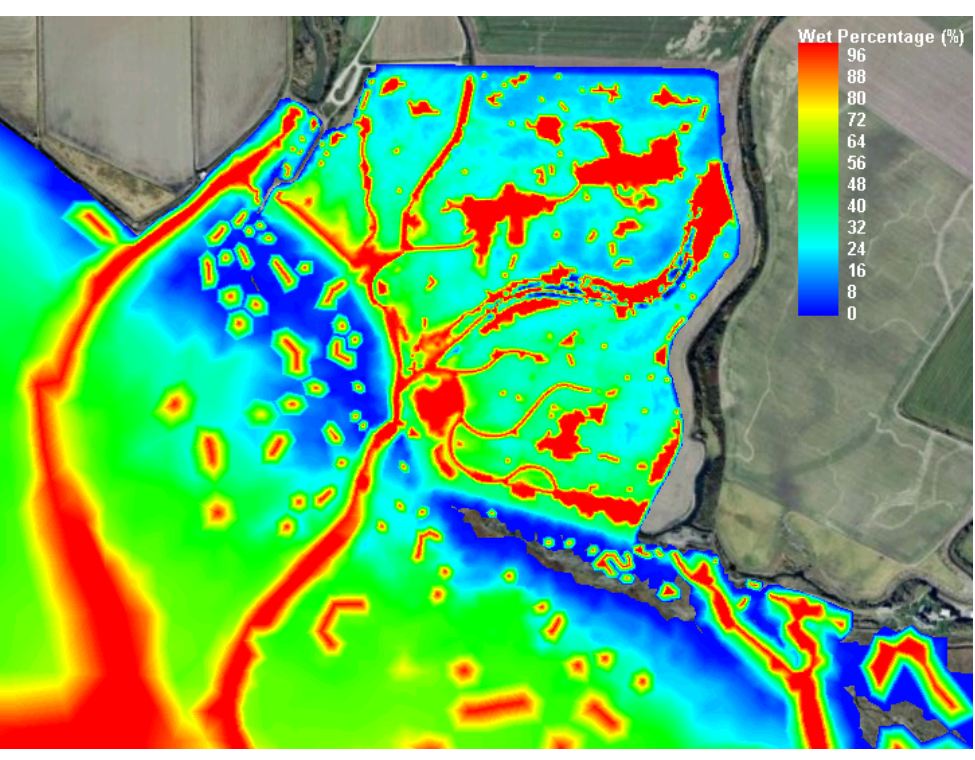
Figure 8. Percentage of inundation time over a 14-day spring-neap tidal